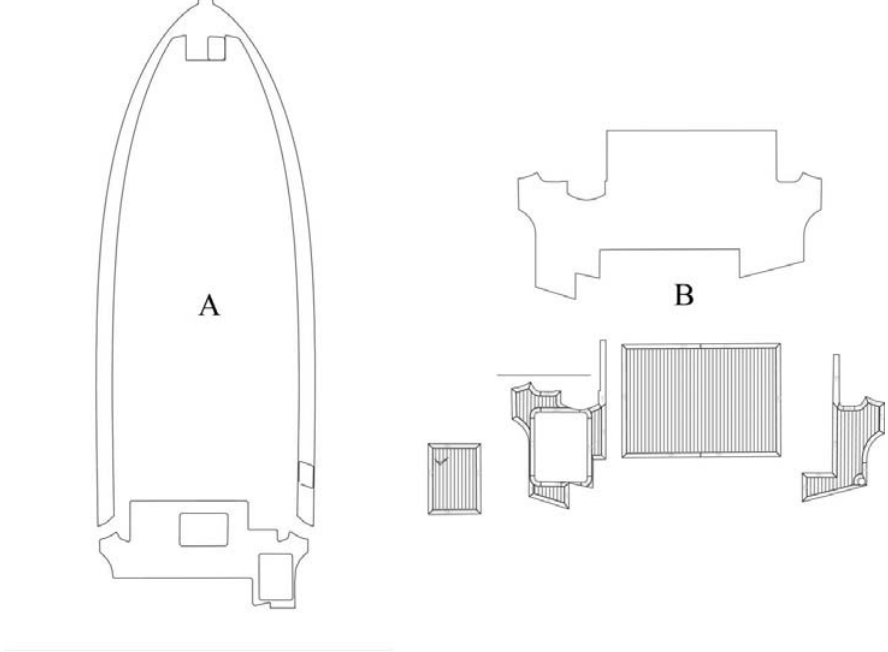
Figure 4. Outlined plans of corridors (A) and cockpit (B) for a Rodman 49